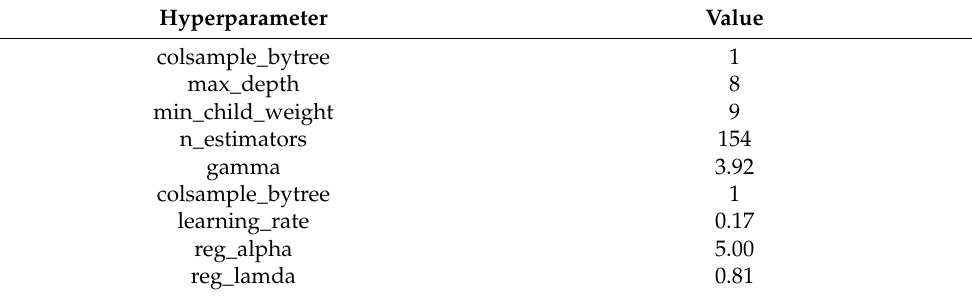
Table 3. Optimal hyperparameters, a wide and deep ensemble model.